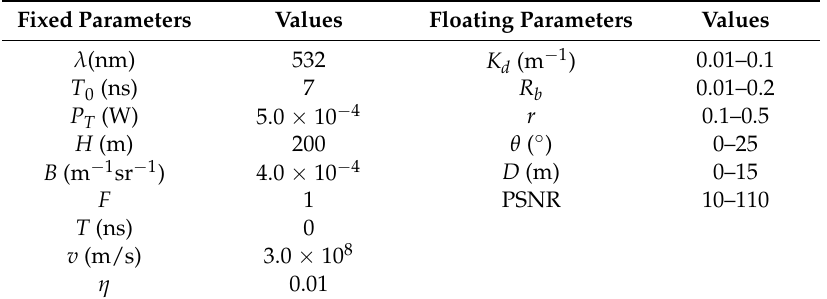
Table 1. Main parameter settings for the simulated dataset.